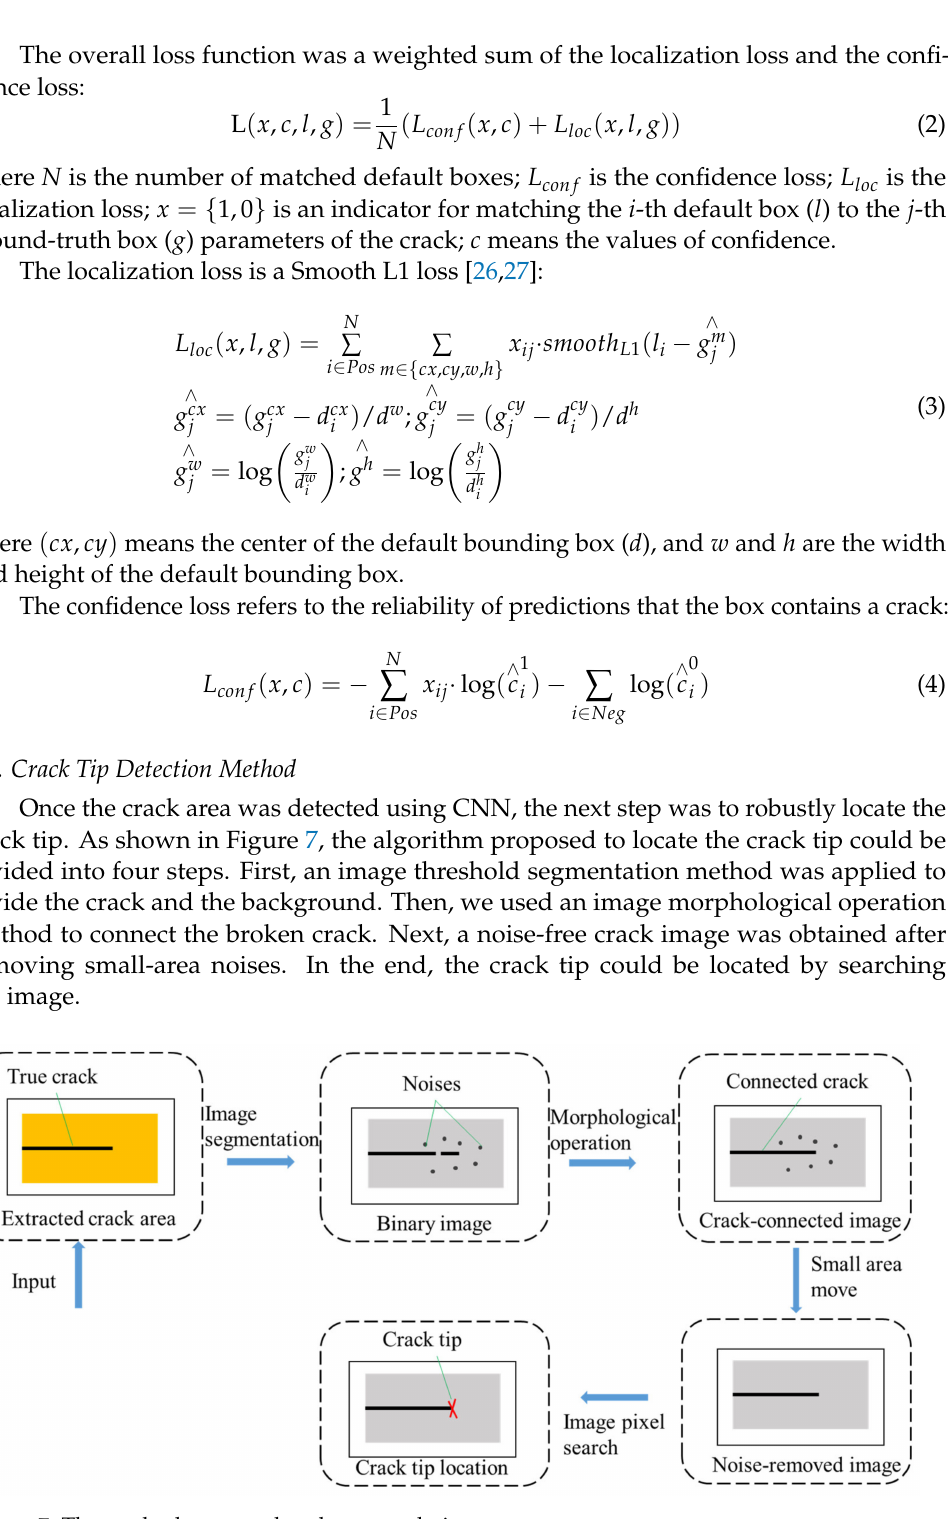
Figure 7. The method proposed to detect crack